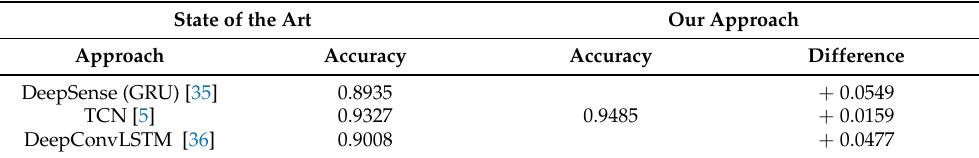
Table 3. The performance. State of the